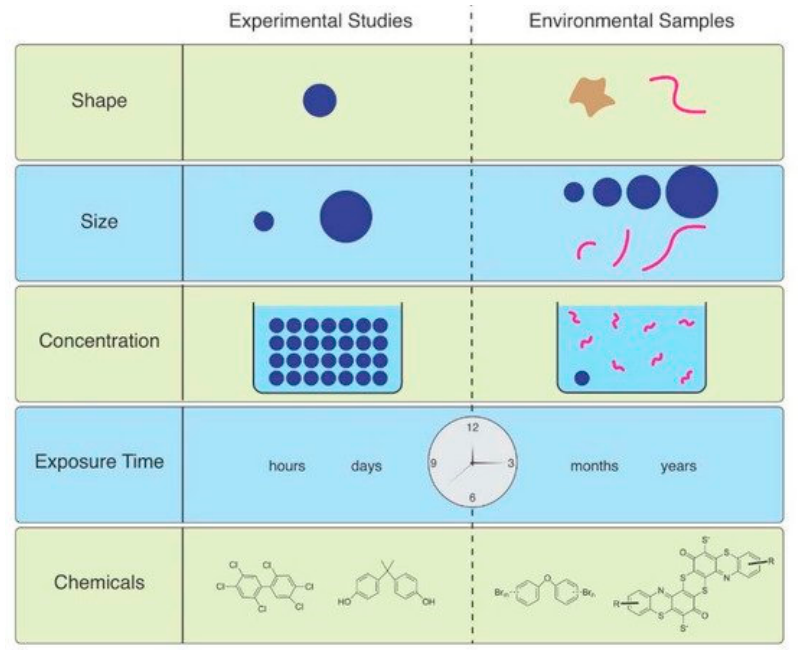
Figure 1. Differences between environmental conditions and experimental microplastic studies. From Weis and Palmquist, 2021. Open access.